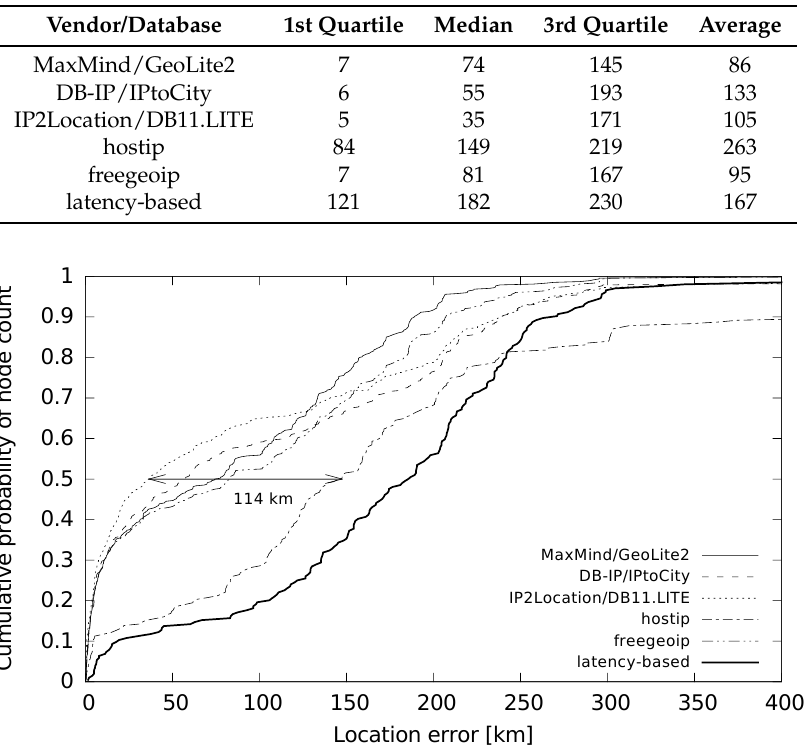
Table 6. Location accuracy—distance error of returned coordinates [km].